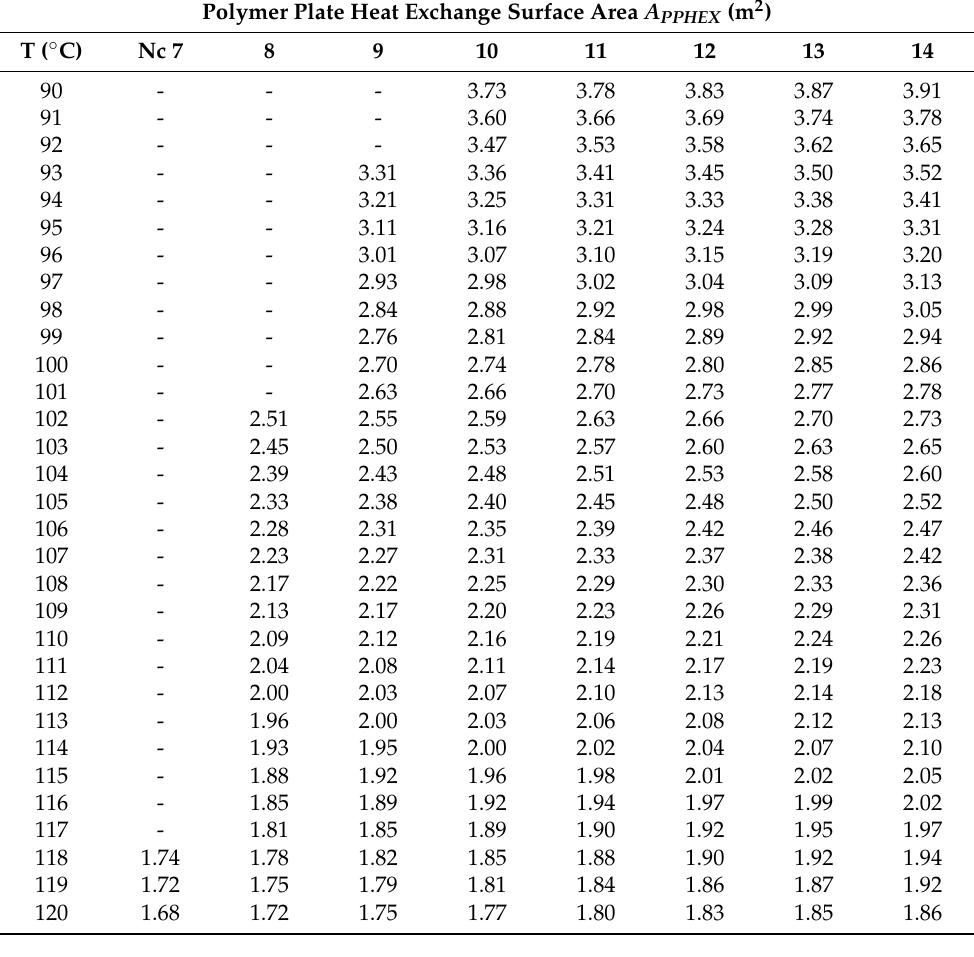
For filtered solutions, the heat exchange surface area of PPEHX is reported in Table 5. It presents a highest value equal to 3.91 m 2 when Nc = 14, and T h , in = 90 ◦ C, while the lowest value is equal to 1.68 m 2 when Nc = 7, and T h , in = 120 ◦ C. The maximum percentage variation of A PPHEX is equal to 57%. So, the optimum solution, in terms of lower footprint, corresponds with best heat transfer performance. Table 5. Heat exchange surface area for matching Nc- T h , in